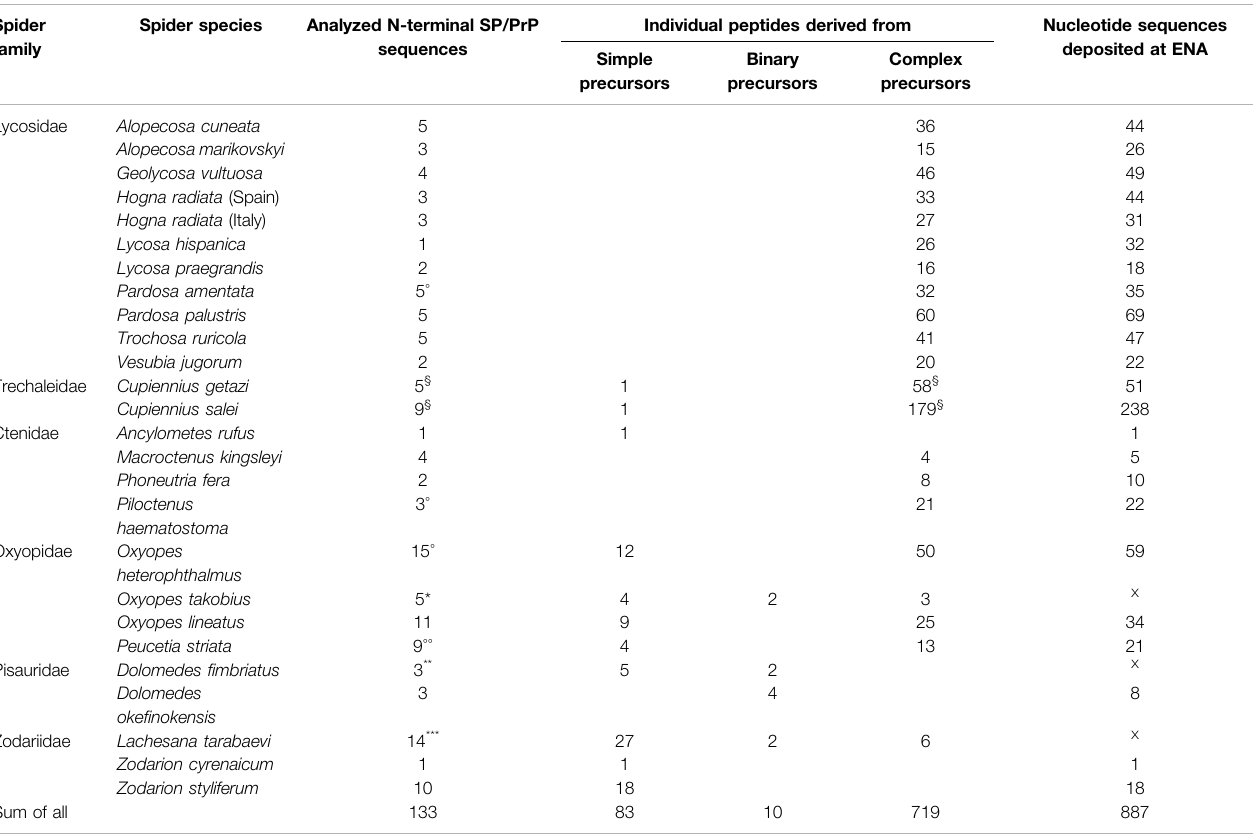
TABLE 1 | Overview of identi fi ed LPs deriving from simple, binary, and complex precursor structures from spider venom gland transcriptomes. Spider Spider family